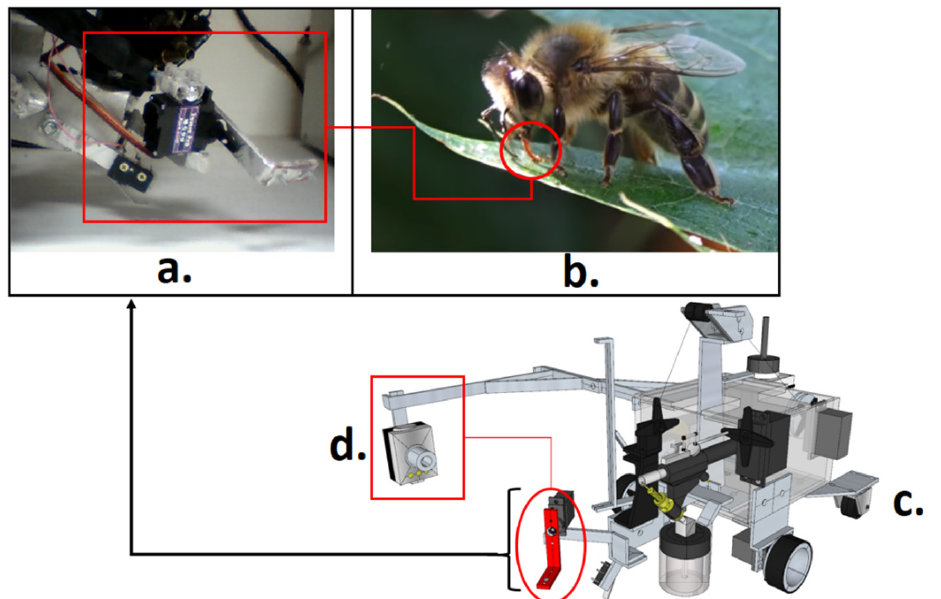
Figure 2. Rover of the bio-inspired probing system: ( a ) Probing system prototype, the image acquired by its side camera; ( b ) Licking system extracting liquids from a leaf; ( c ) Rover’s three-dimensional project including the side camera, probing system, and locomotion platform; ( d ) Side camera and the filmed Licking system model.